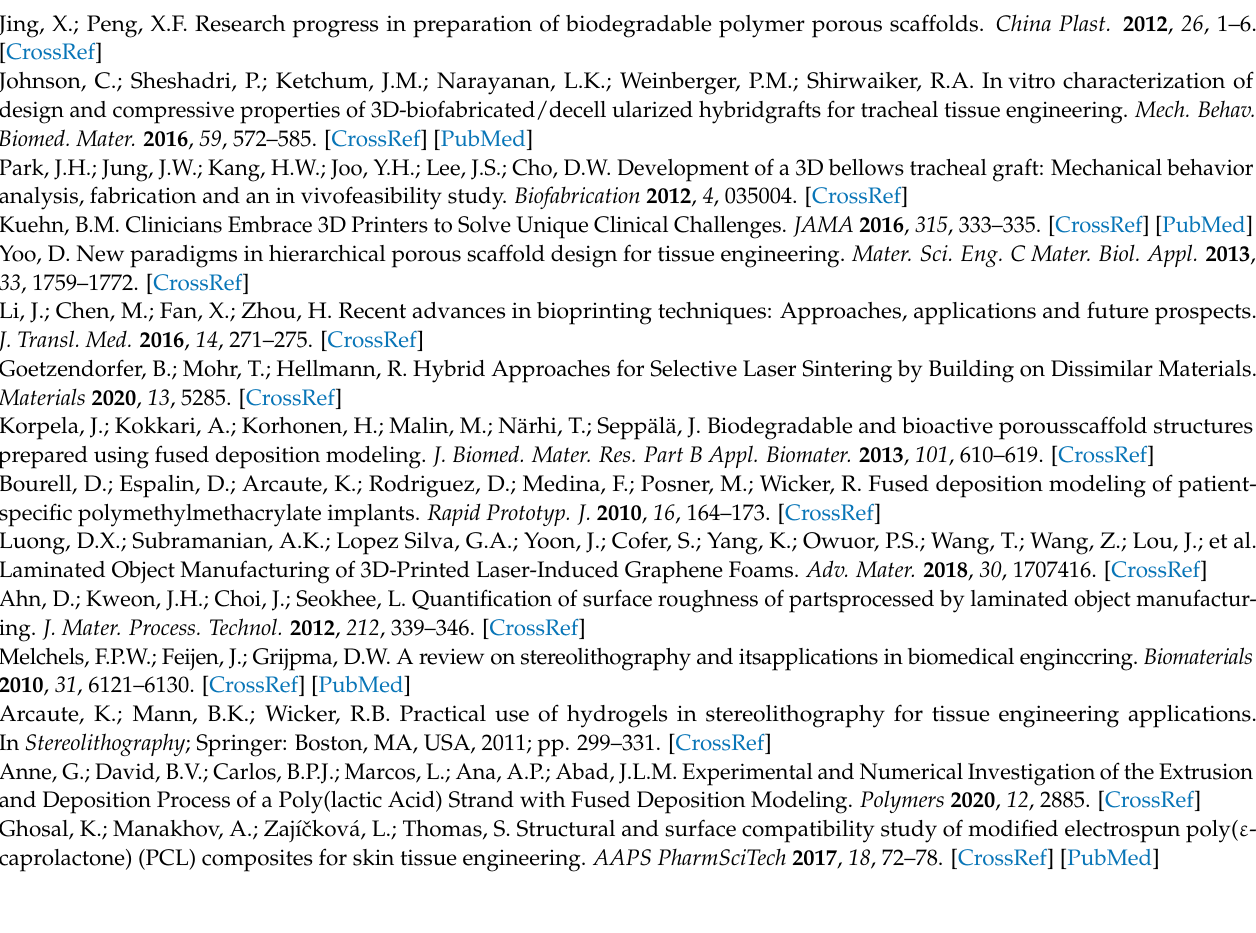
Figure S4: Layout diagram of strain gauge. Figure S5: XRD scanning pattern of PCL/CNC nanocom- posites with various amounts of CNC. Table S1: The optimal parameters when printing different filling